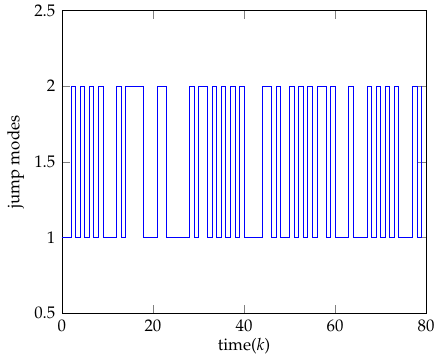
Figure 1. The Markov jump